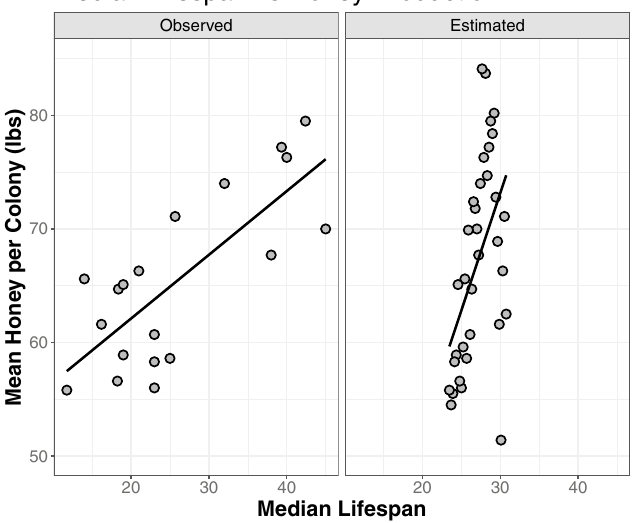
Figure 4. Median lifespan of caged bees, either mean observed or model estimated per year vs mean honey produced per colony in the US